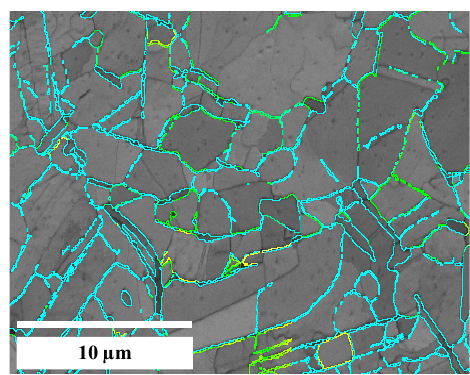
Figure 10. Sample B. OIM, orientation relationship (yellow > 10°, lime green > 20° and turquoise > 30°), phase limits.